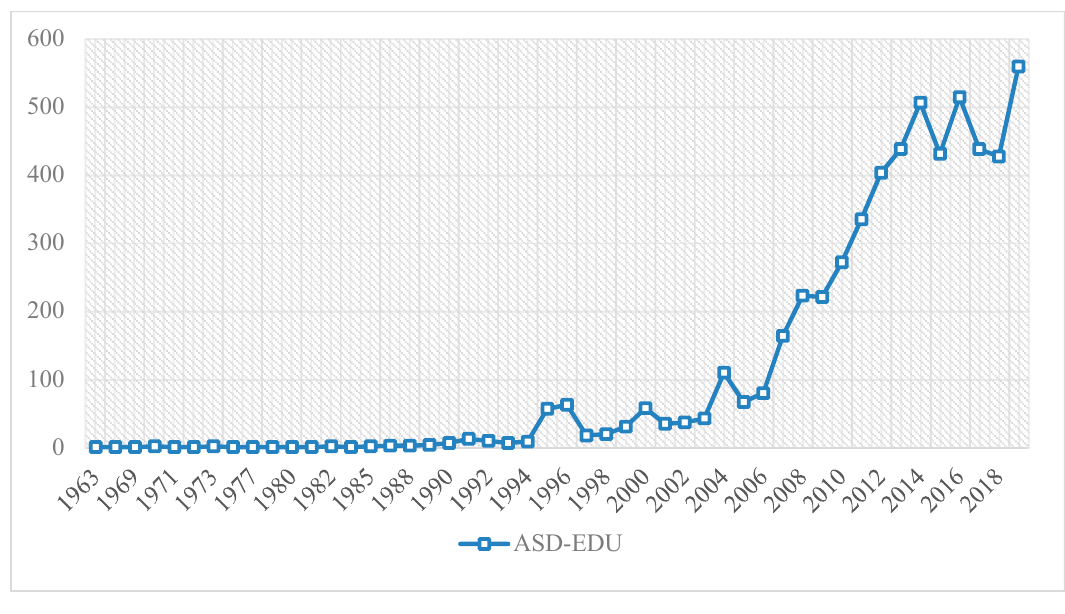
Figure 2. Evolution of scientific production.